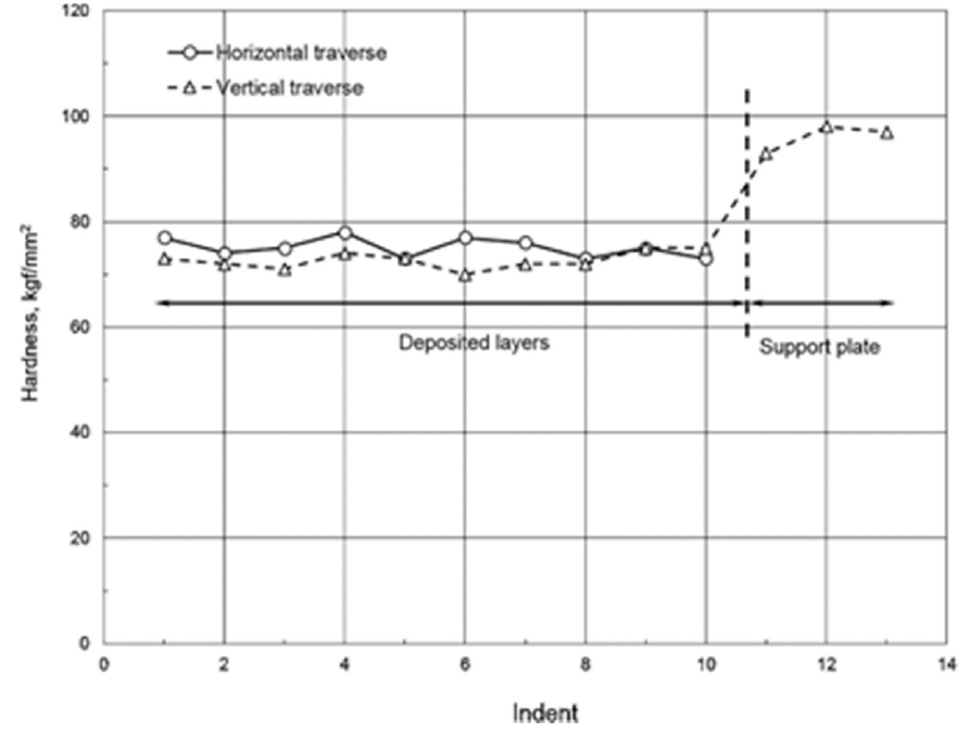
Figure 31. Horizontal and vertical hardness traverse perpendicular to the deposited